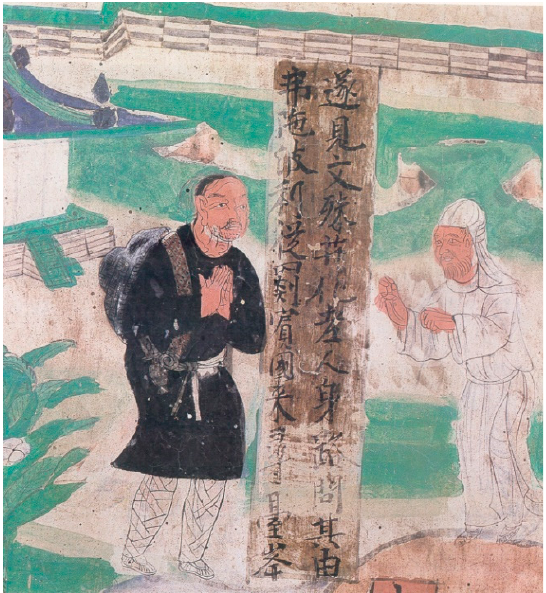
Figure 9. Buddhap ā lita meeting an incarnation of Ma ñ ju ś r ī , detail of the Panoramic View of Mount Wutai on the west wall of Mogao Cave 61, Mid-10th Century. Reproduced by permission of The Commercial Press (Hong Kong) Limited from the publication of Art of Dunhuang Caves 12 ( 敦煌石窟 全集 12, ISBN: 9620752732).